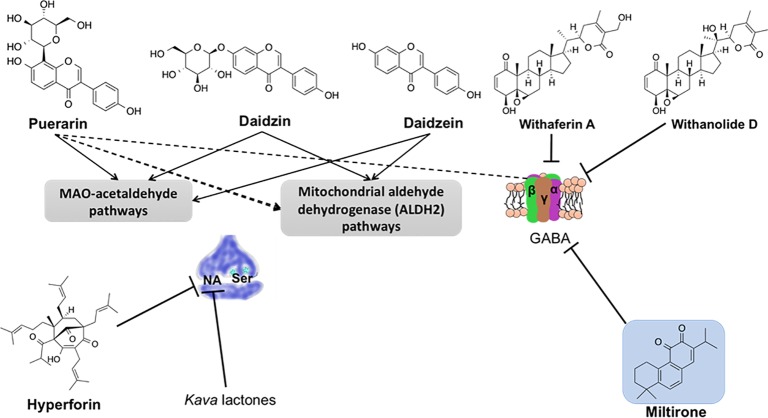
Possible mechanism of action of some of phytoconstituents in the context of counteracting alcohol abuse. Puerarin, daidzein, and daidzin decrease alcohol consumption by alterations in MAO-acetaldehyde pathways or mitochondrial ALDH2 pathways (Keung, 2003; Lukas et al., 2013); Withaferin A and withanolide D block GABA receptors binding and upsurges chloride influx in absence of GABA (Gupta and Rana, 2008; Lu et al., 2009; Ruiu et al., 2013); Kava lactones bind to multiple locations in the brain and interact with different neurotransmitters and significantly inhibit the uptake of noradrenaline, but not serotonin (Sällström Baum et al., 1998); Militirone is low-affinity ligand for central GABAA-BDZ–binding site, thus acting as a partial agonist and implying an anxiolytic effect (Lee et al., 1991).